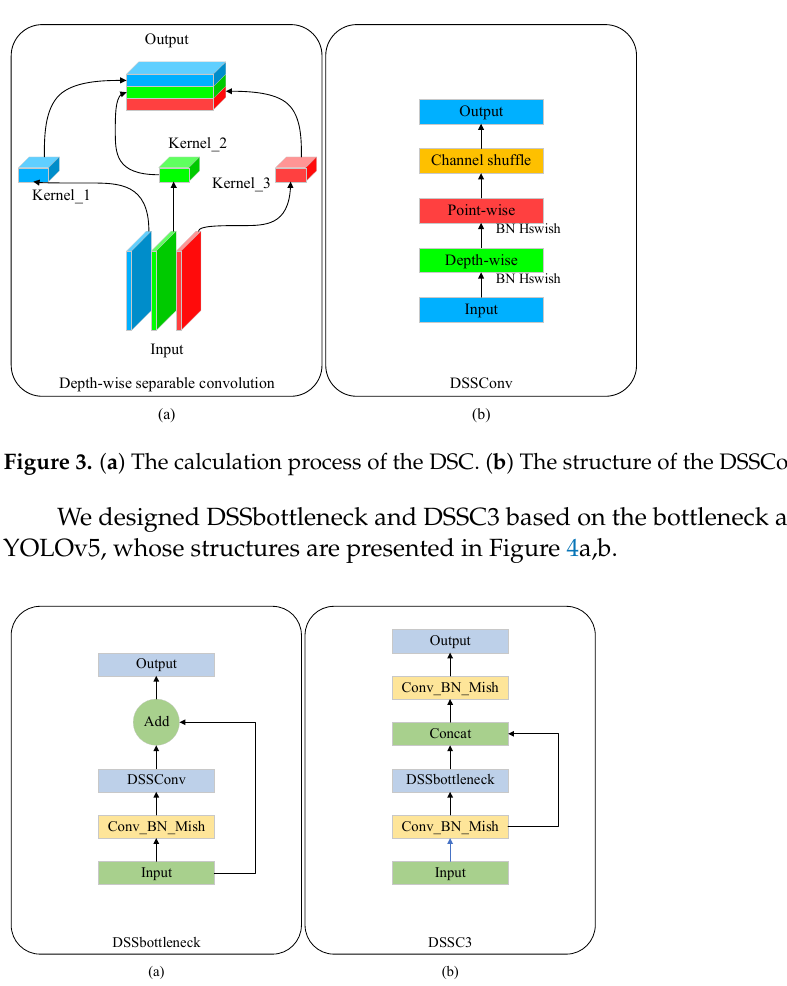
Figure 4. ( a ) The structure of the DSSbottleneck module. ( b ) The structure of the DSSC3 module. YOLOv5 uses PANET [20] on the neck to perform feature extraction and fusion. It uses bottom-up and top-down bidirectional fusion methods and achieves good results.